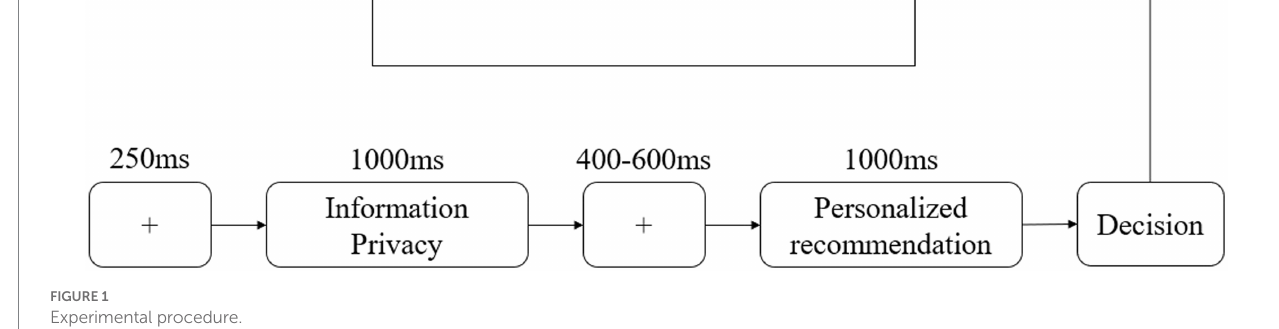
FIGURE 1 Experimental procedure.